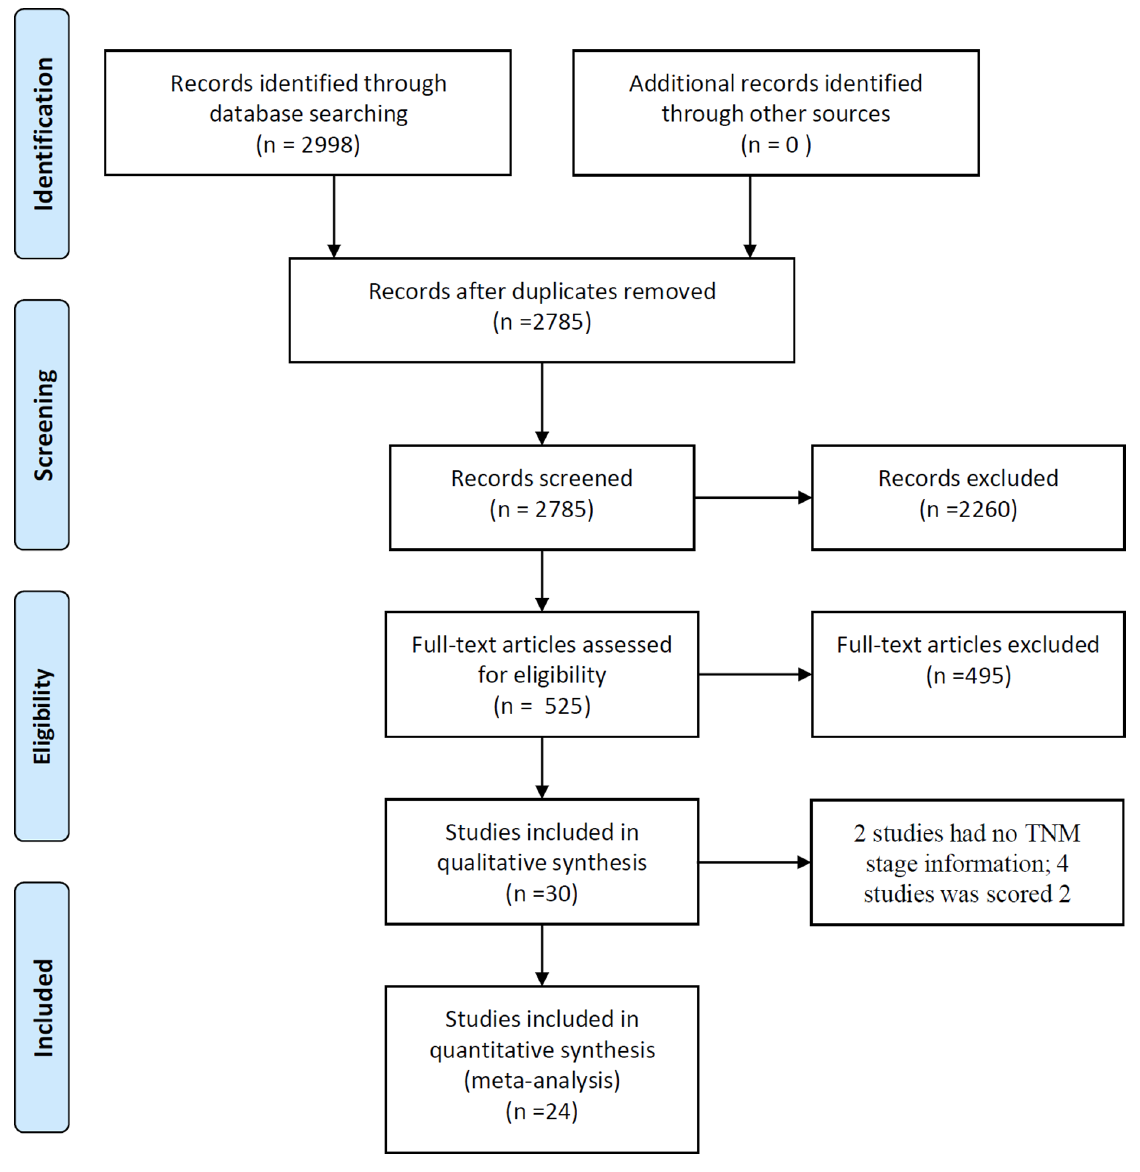
Figure 1. Flow chart of study selection.